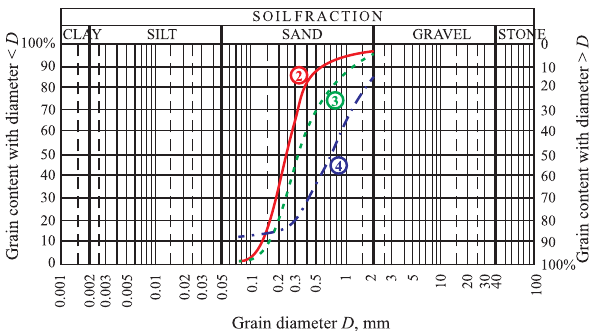
Fig. 2. Grain-size distribution curves from sieve analysis for soils tested in the laboratory